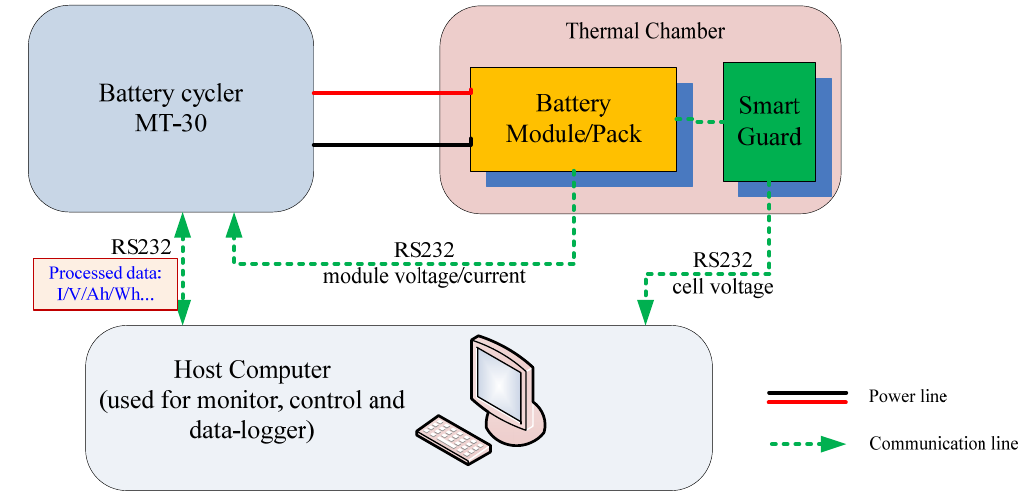
Figure 4. Configuration of the battery test